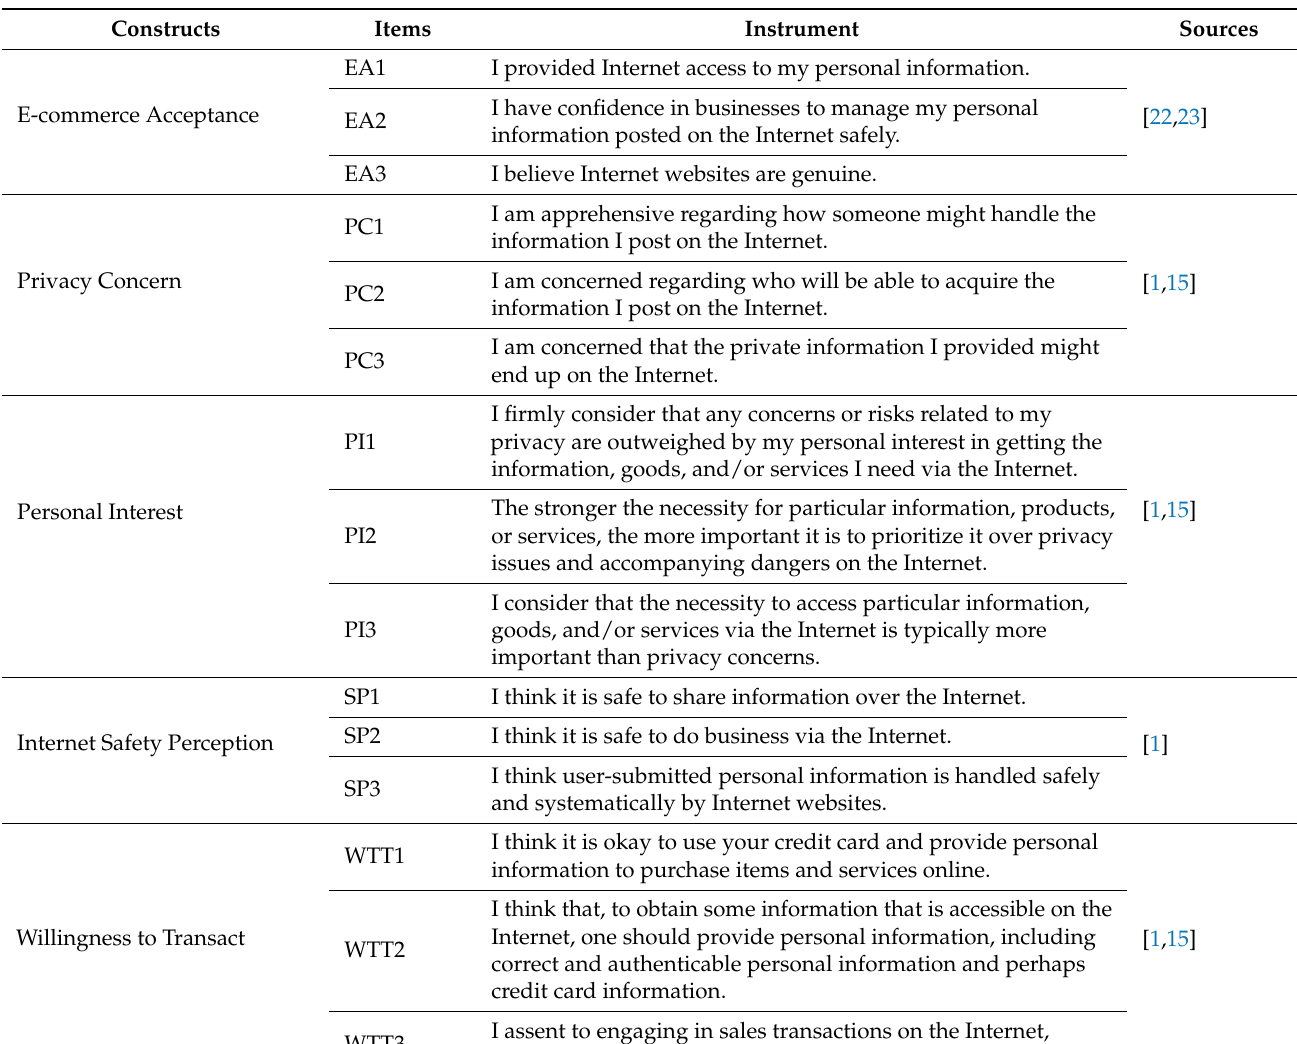
Table 1. Measurement